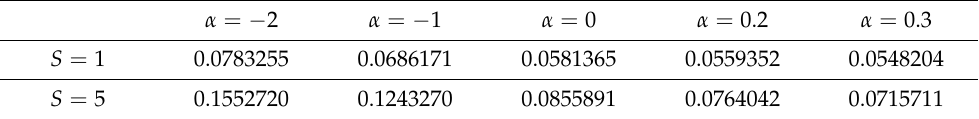
Table 4. Numerical outcomes for the Nusselt number Re − 1/2 Nu with a varying wall temperature parameter [26] and fixing K vs = 0.5, λ = 0.5, Ω = 0.5, Sc = 1,Pr = 1, K s = 0.5, K c = 0.5. α = − 2 α = − 1 α = 0 α = 0.2